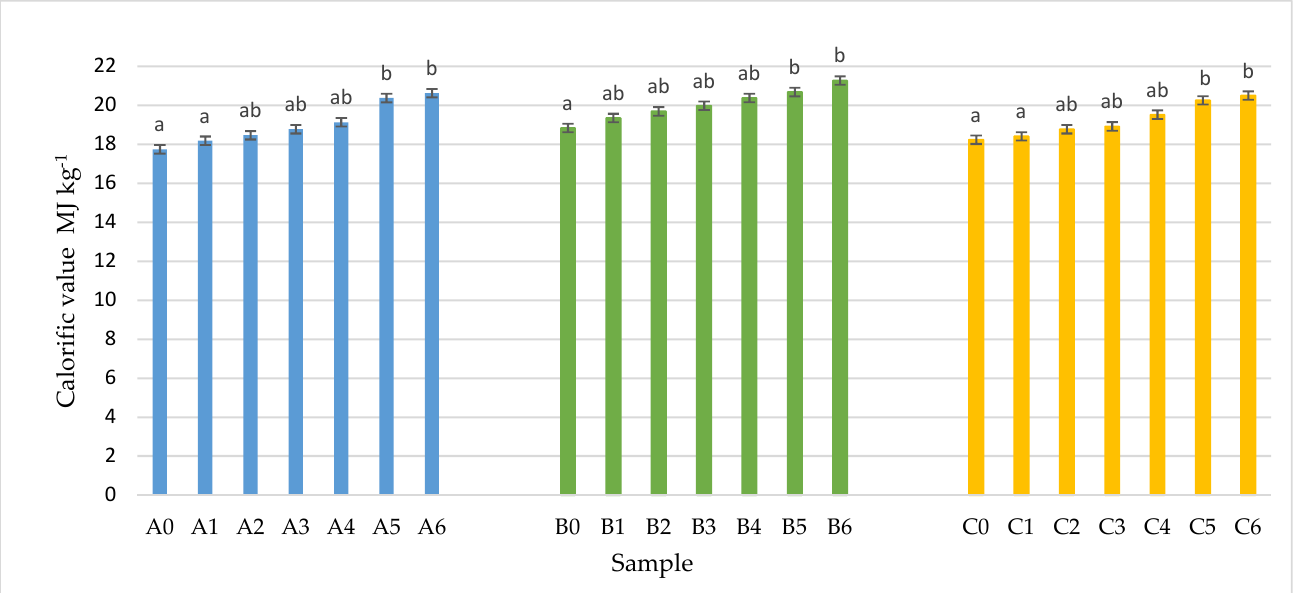
Figure 3. Calorific value of samples of deciduous woods pellets before and after waste cooking oil was added by spraying. Statistically significant differences marked by different letters ( p ≤ 0.05). Differences between average values marked with the same letters (a,b) are not statistically significant at the level of p ≤ 0.05 according to the Duncan test. The data were analysed separately for each type of pellet.